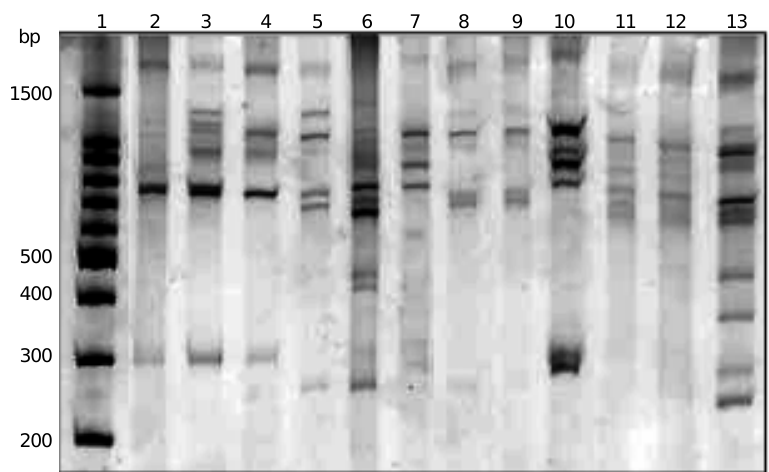
Figure 1. PCR-LIS-SSCP analysis of HLA-DQA1 group alleles. Lane 1 : Molecular weight marker (100-bp DNA ladder; Promega); lane 2 : DQA1*0101+0103; lane 3 : DQA1*0102+0103; lane 4 : DQA1*0102+0102; lane 5 : DQA1*0101+0501; lane 6 : 0101+0201; lane 7 : DQA1*0102+0301; lane 8 : DQA1*0501+0501; lane 9 : DQA1*0501+0501; lane 10 : DQA1*0102+0301; lane 11 : DQA1*0301+0501; lane 12 : DQA1*0301+0501; lane 13 : DQA1*0103+0501. Electrophoresis was carried out on a 10% gel at 4 o C for 5